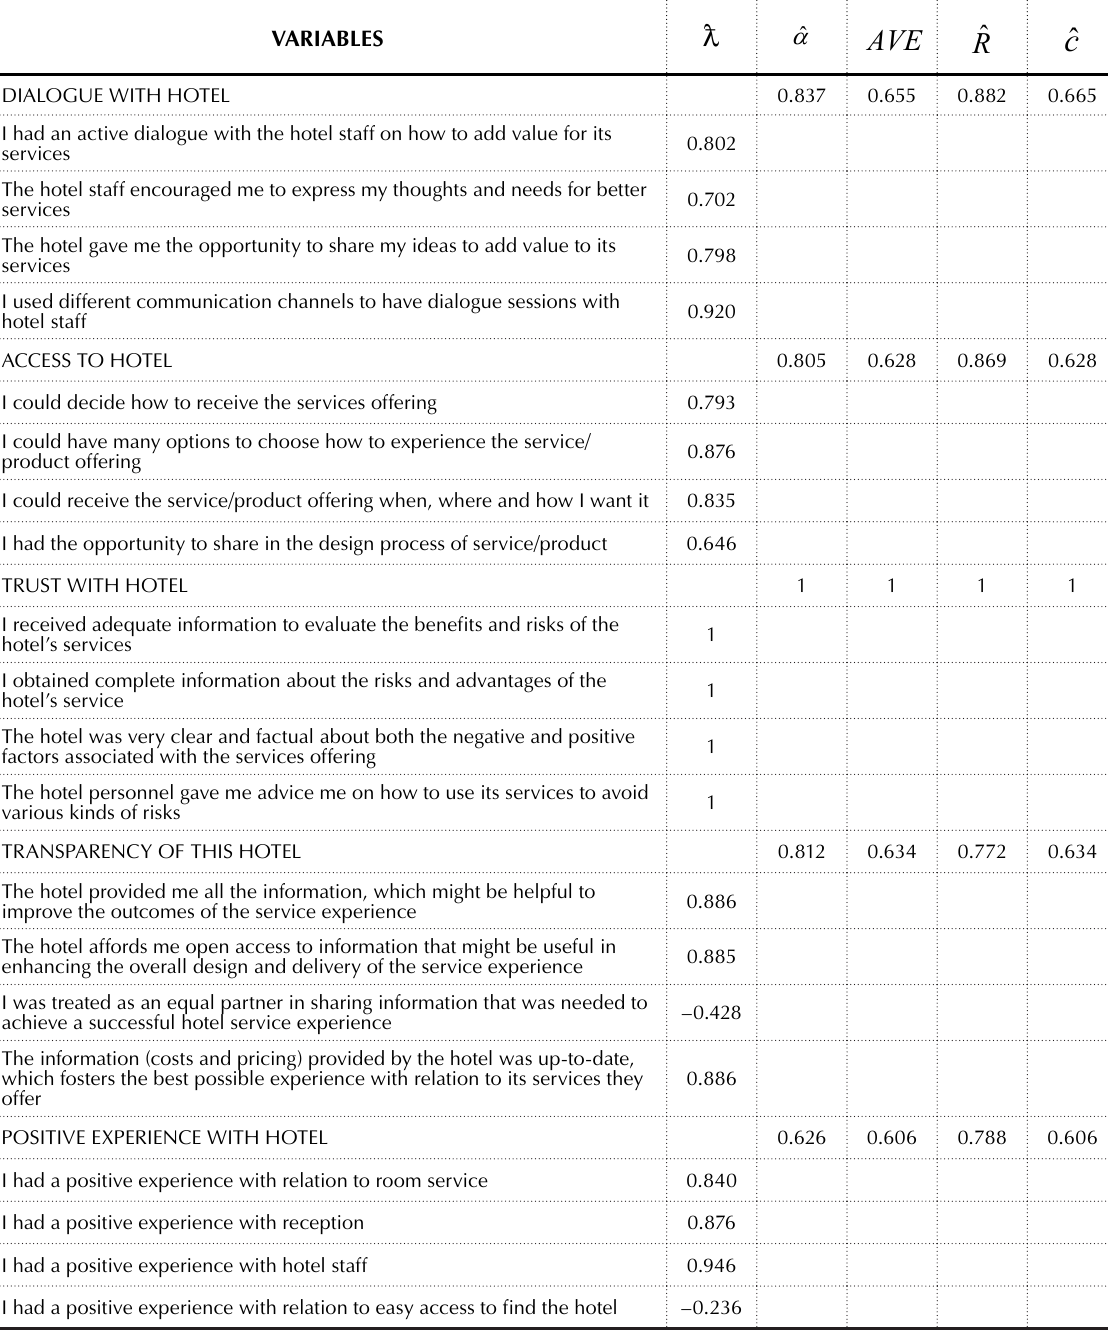
Table 2. Constructs and its results